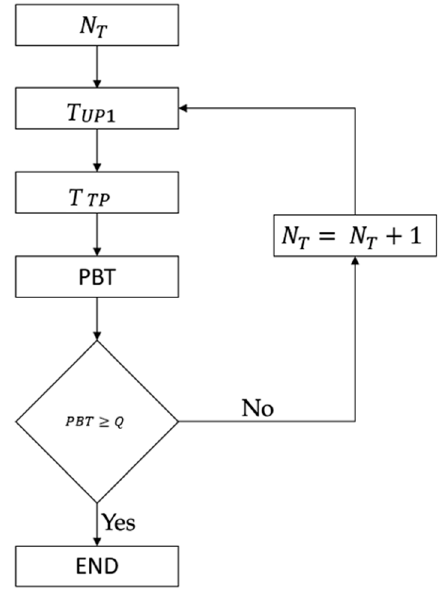
Figure 6. Representative algorithm flowchart.